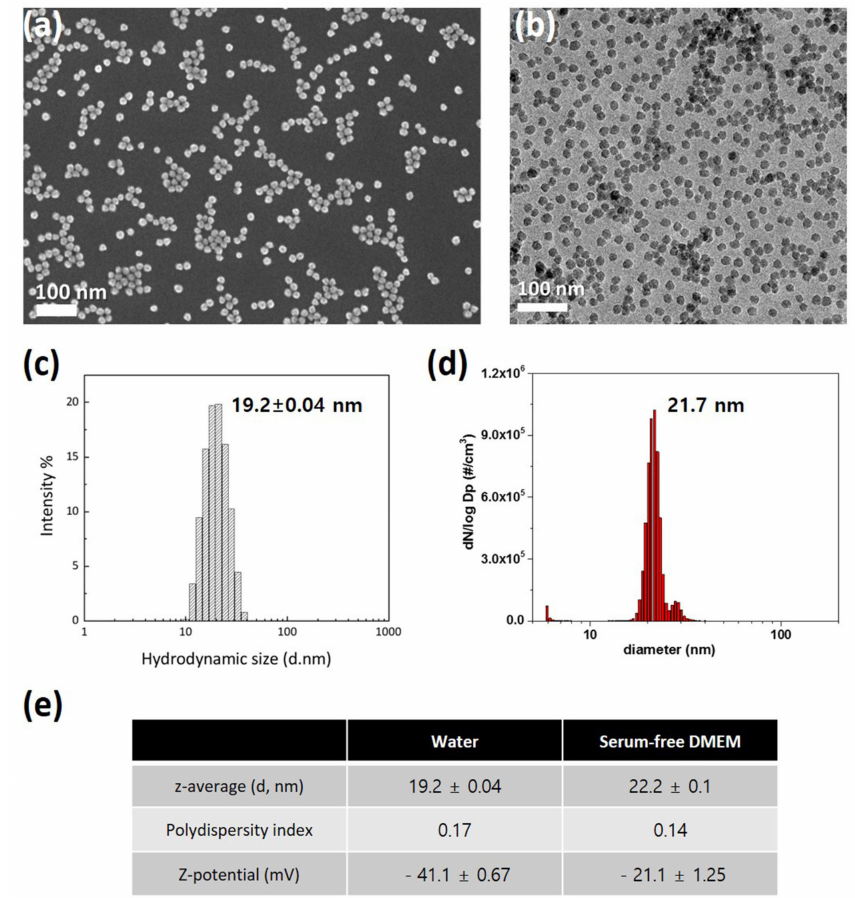
Figure 1. Characterization of 20 nm SiO 2 NPs: ( a ) Scanning electron microscopy image; ( b ) Trans- mission electron microscopy image; ( c ) Dynamic light scattering size analysis; ( d ) Scanning mobility particle sizer analysis; ( e ) Performance comparison in deionized water and serum-free